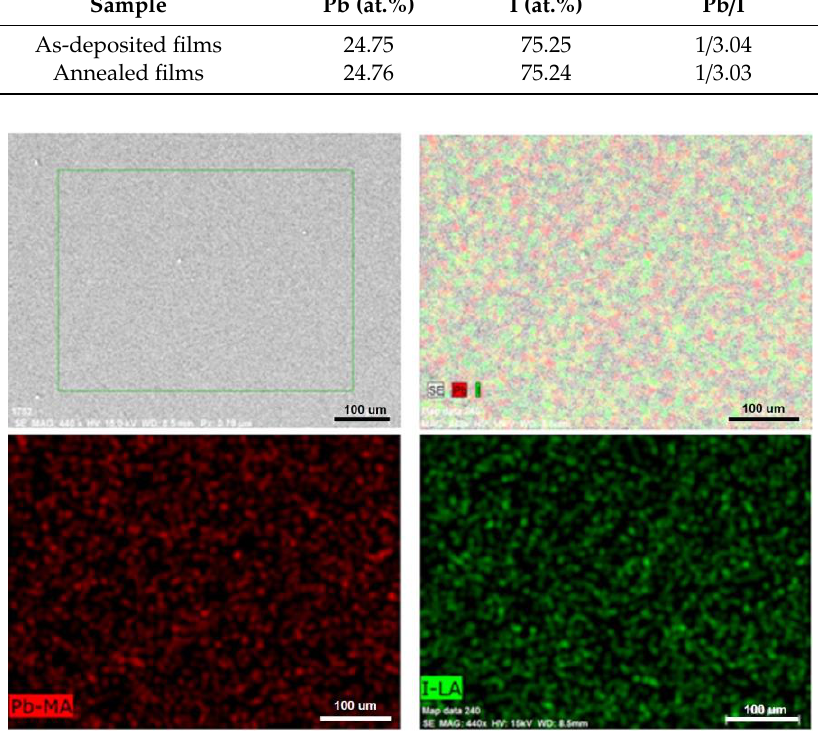
Figure 4. The elemental mapping of Pb and I in the solvent-annealed CH 3 NH 3 PbI 3 film.